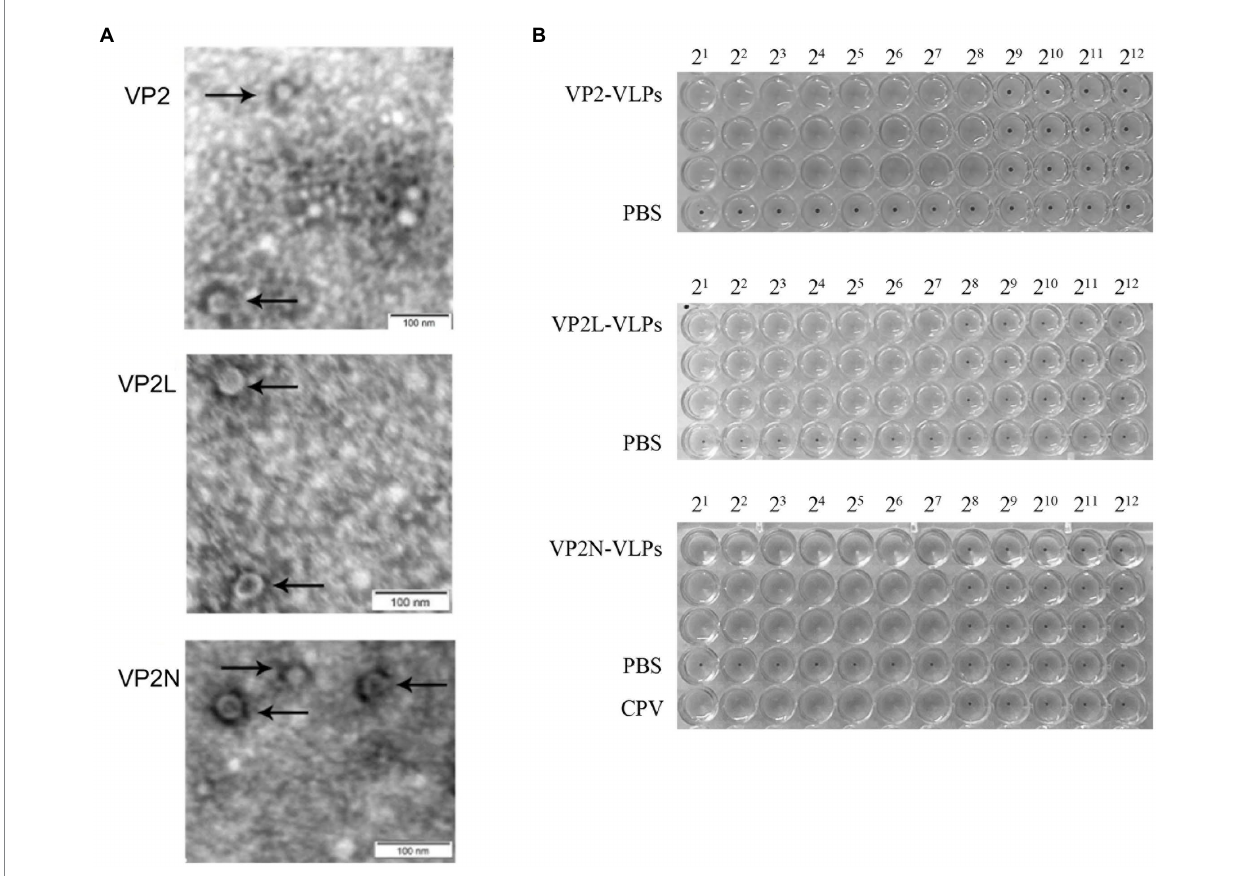
FIGURE 4 Characterization of wild-type and chimeric CPV VLPs by electron microscopy and HA test. (A) Electron micrographs of CPV VLPs, 80,000×; (B) Determination of HA titers of CPV VP2, VP2L and VP2N